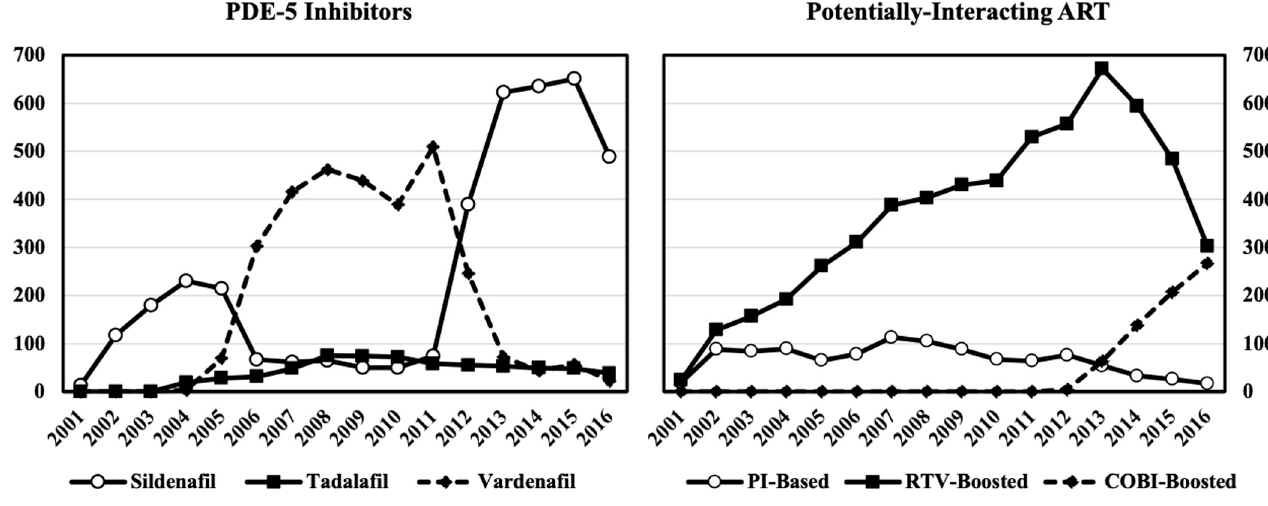
Fig 2. Number of PDE-5 inhibitor and potentially-interacting ART dispensed by year of study.